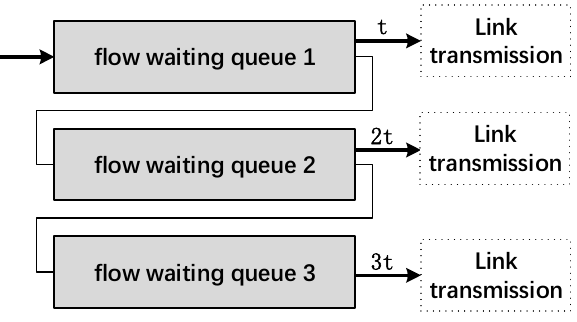
Figure 3. Multilevel feedback queue.